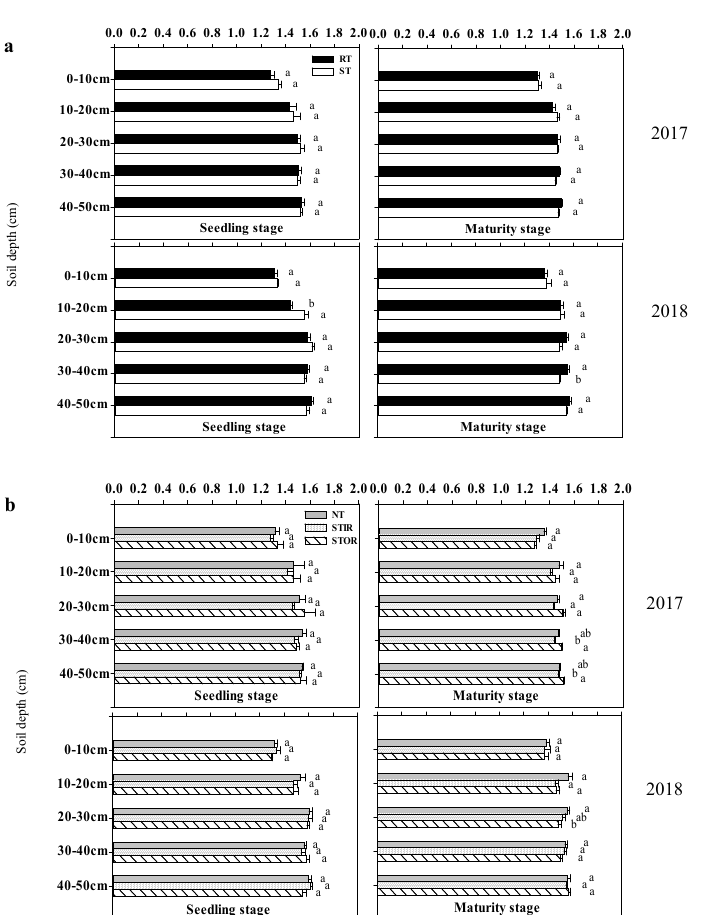
Figure 1. Effects of different tillage practices on soil bulk density in maize season. ( a ) wheat season tillage; ( b ) maize season tillage. RT: rotary tillage; ST: subsoiling tillage; STIR: inter–row subsoiling tillage; STOR: on–row subsoiling tillage. Different letters indicate statistically significant differences at the p < 0.05 level (ANOVA and Duncan’s multiple range test; n = 3), the same letters are not significantly different between two